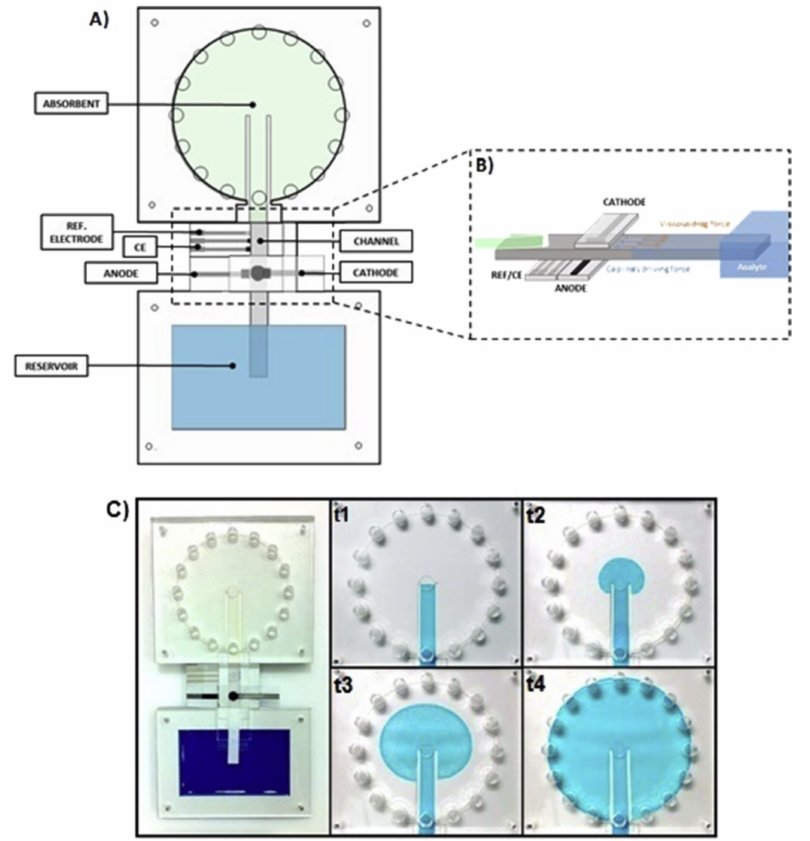
Figure 11. Schematic drawing of the glucose paper-based enzymatic cell described in [46]: ( A ) and cross-sectional view of the individual components (anode/cathode, reference/counter electrodes) ( B ); absorbent pad filling at four different times generating the quasi-steady flow of the device ( C ). Reprinted from [46], with permission from